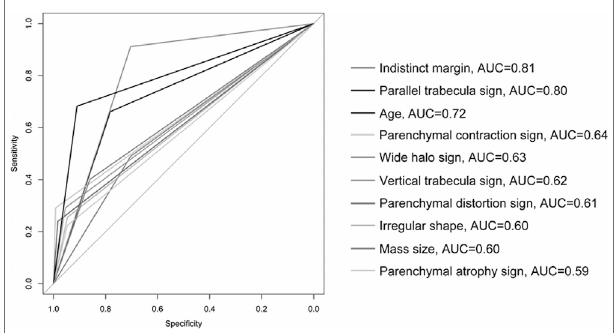
FIGURE 6 | ROC curve of independent malignant risk factors. The optimal cut-off47.5wasselectedusing theagepredictionmodel. Theoptimal cut-off 22.5 was selected using the size prediction model. The fi gure was edited using Adobe illustrator (version number CS6) (without changing the